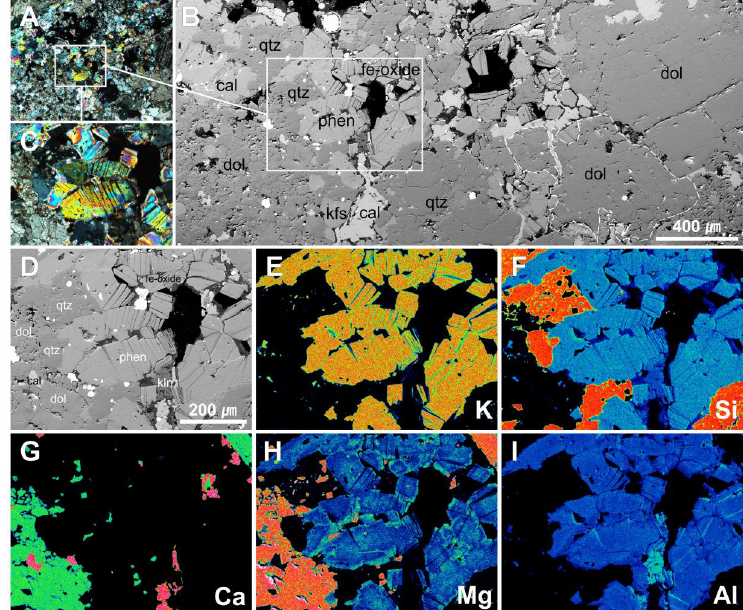
Figure 6. ( A , C ) XPL images of typical well-crystallized euhedral to subhedral flaky phengite (Type 3) with 100 to 300 μm in size; ( B ) SEM-BSE image of well-crystallized phengites (Type 3) precipitated around the dolomite pebble, crystalline dolomite and quartz and followed calcite filling; ( D ) SEM-BSE image of Type 3 phengite for element-mapping and the element-mapping results of the BSE imaging part for ( E ) K, ( F ) Si, ( G ) Ca, ( H ) Mg and ( I ) Al. Abbreviations: qtz—quartz; cal—calcite; dol— dolomite; phen—phengite; kfs—K-feldspar. Phengite series is a dioctahedral solid solution between two end-members of muscovite [K 1 [Al 2 ] VI [Al 1 ,Si 3 ] IV O 10 (OH) 2 ] and celadonite [K 1 [(Fe 3+ ,Al) 1 ,(Mg,Fe 2+ ) 1 ] VI [Si 4 ] IV O 10 (OH) 2 ]. The relation between Al total atoms per formula unit (apfu) versus sum of Si, Mg and Fe (apfu) can define the hetero-valent substitution of Al VI Al IV ↔ (Mg,Fe) VI Si IV for charge-balancing in the phengite-series solid solution. All data are plotted on the muscovite to aluminoceladonite substitution line with a distinctly different range for each phengite type (Figure 7). The plots of polycrystalline aggregate phengite (Type 1) are clearly divided into two types (Type 1a and 1b), which are due to the distinct difference in Mg and Al contents (Figure 7, Table 1). The plots of pore-filling type phengite (Type 2) are similar to those of Type 1b phengites, whereas those of well-crystallized phengite (Type 3) are plotted in the relatively high-Al region. The number of Mg atoms per formula unit (apfu) of these Mg-phengites ranges from 0.00 to 0.70 with no Fe (Table 1 and Figure 7). Plots on the diagram of Al(VI) versus Si(IV) (Figure 8A) and Mg(VI) versus Si(IV) (Figure 8B) based on atoms per formula unit (apfu) for the Type 1, 2, and 3 phengites strongly indicate the trends of theoretical hetero-valence substitution of Al VI Al IV ↔ (Mg, Fe) VI Si IV for charge-balancing in the phengite-series solid solution (Figure 8).